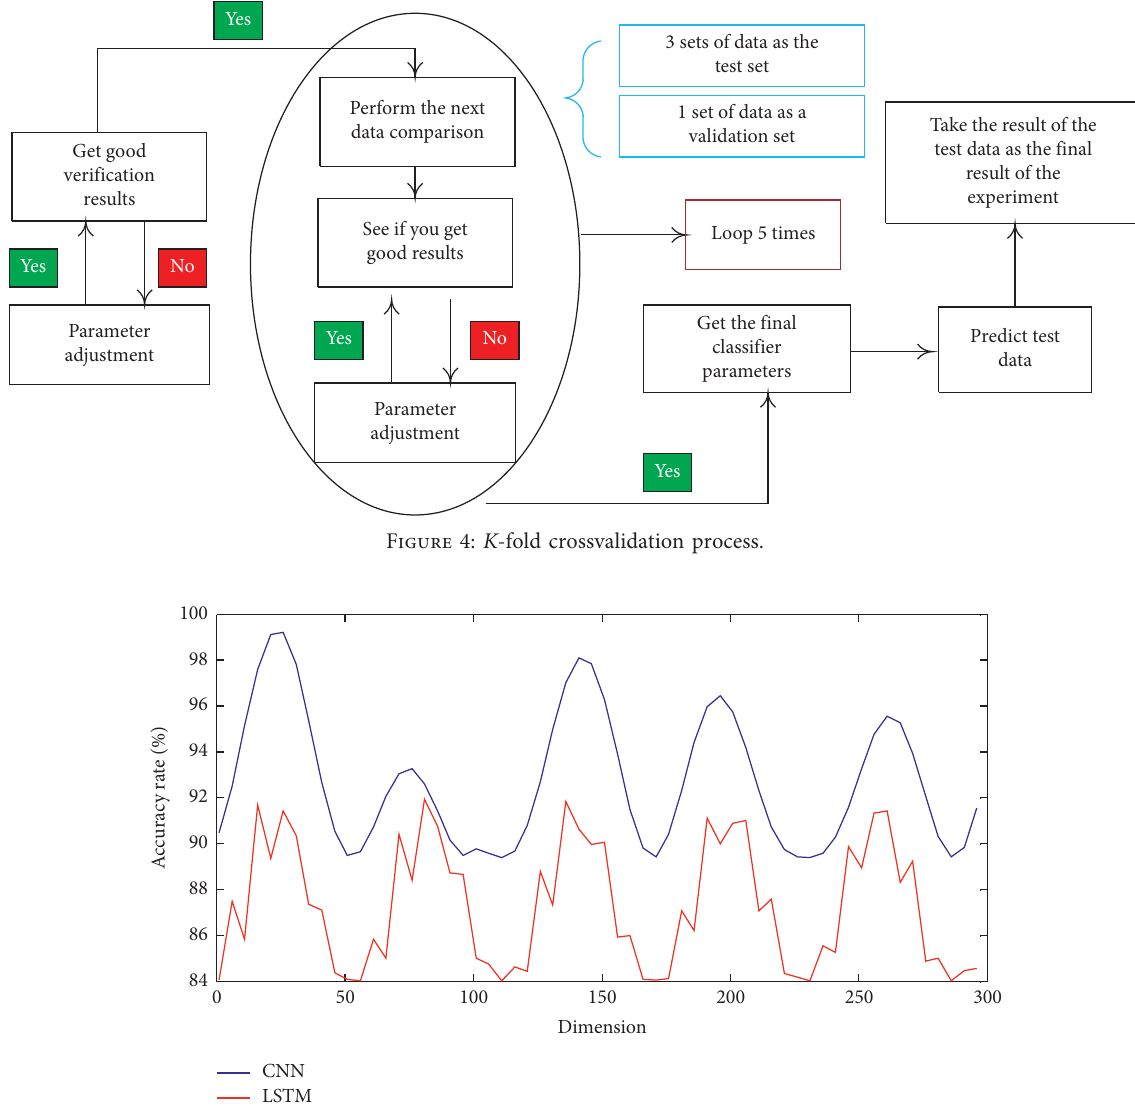
Figure 5: Word2Vec word vector detection level F 1 results in